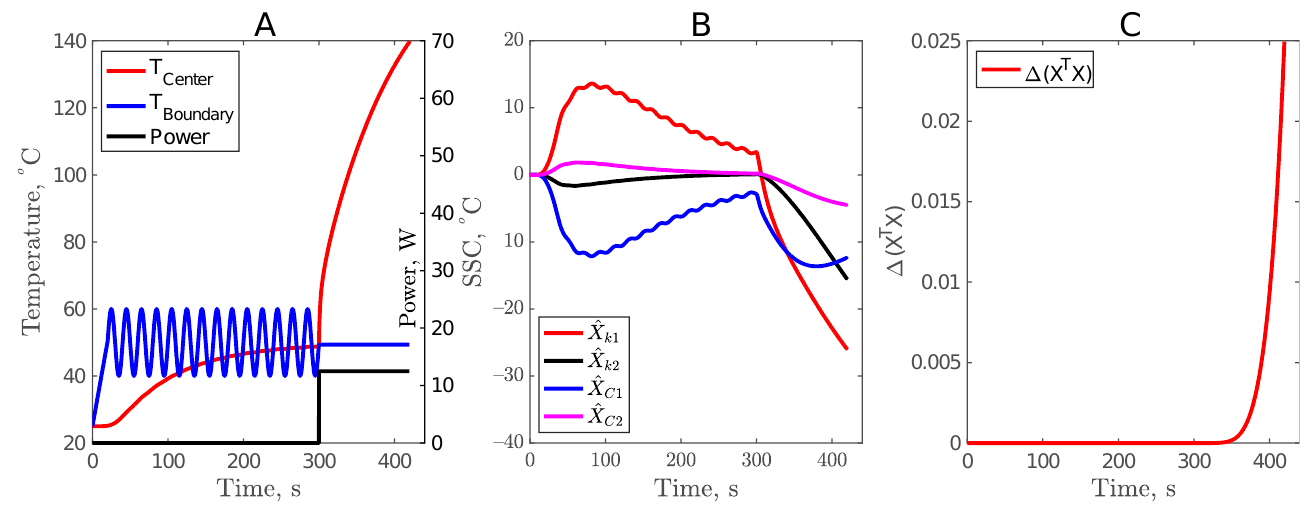
Figure 4. Center temperature profile with power input ( A ), scaled sensitivity coefficients ( B ), and criteria for optimal design ( C ) for the experiment with sinusoidal boundary temperature.